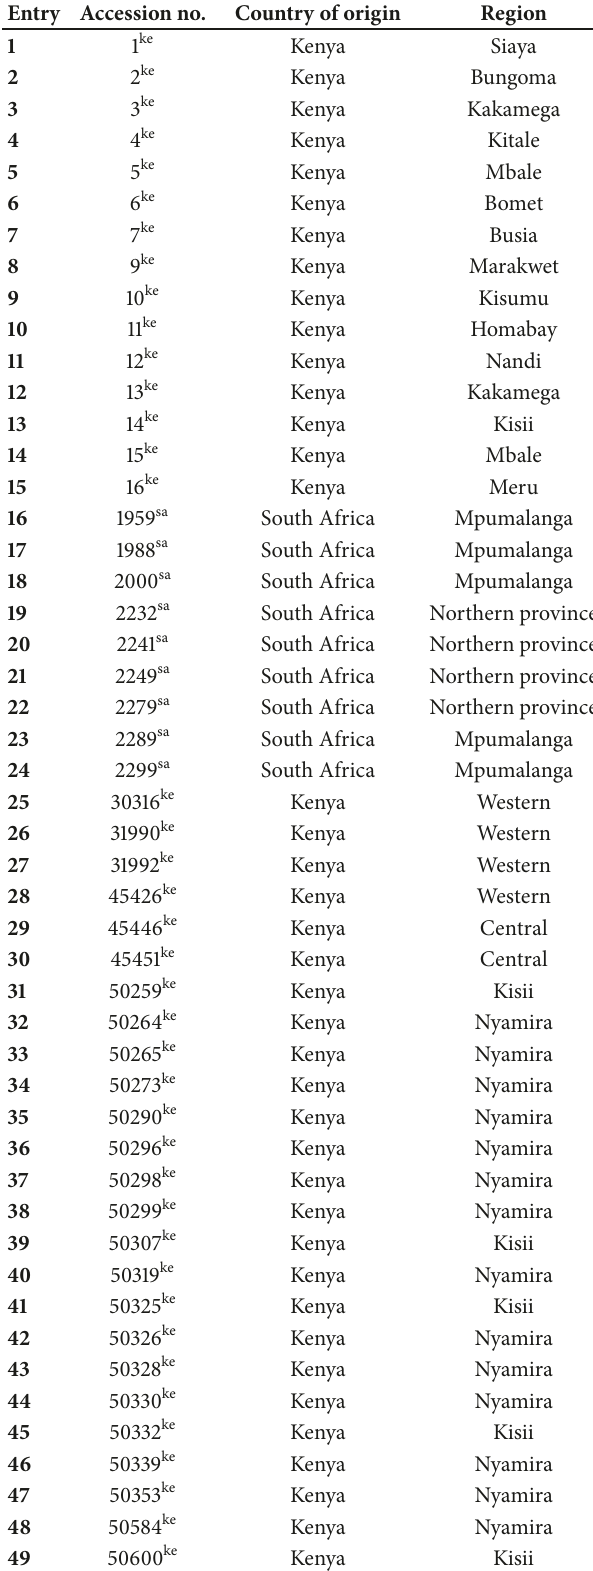
Table 1: List of Kenyan and South African spider plant accessions evaluated in the